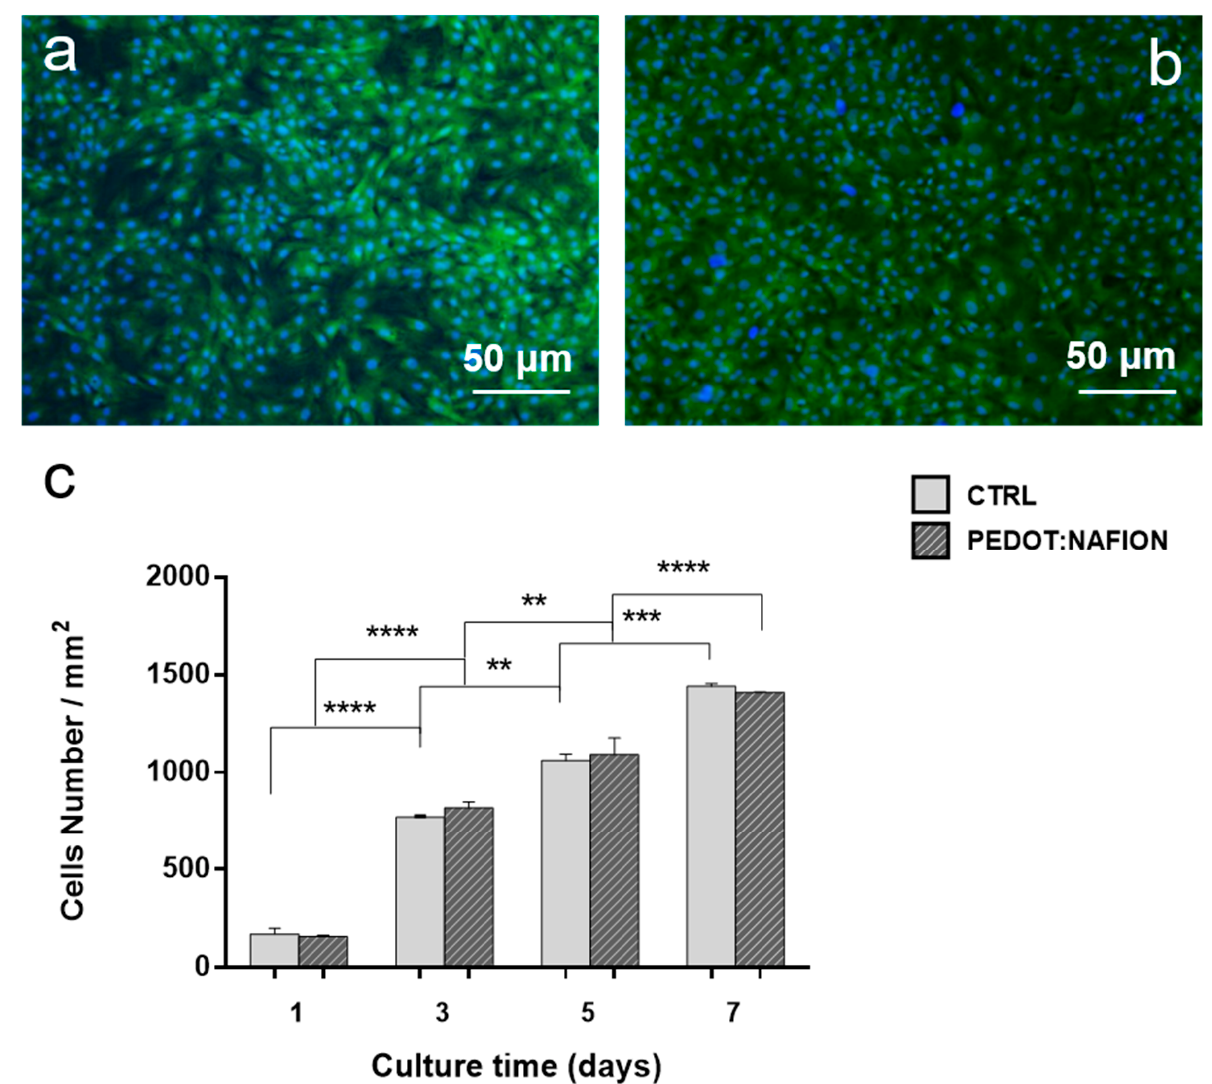
Figure 4. Cells proliferation on PEDOT:Nafion. Fluorescence images of primary rat fibroblasts stained with FDA (green) and Hoechst (blue) after 5 days from seeding on glass control ( a ) and PEDOT:Nafion coating ( b ); cell density ( c ) at different time points (** p < 0.01, *** p < 0.001, **** p < 0.0001).